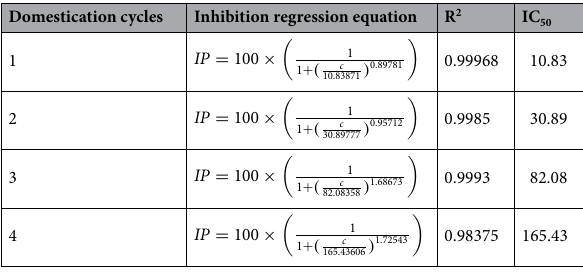
Table 3. IC 50 determination with different domestication cycles.